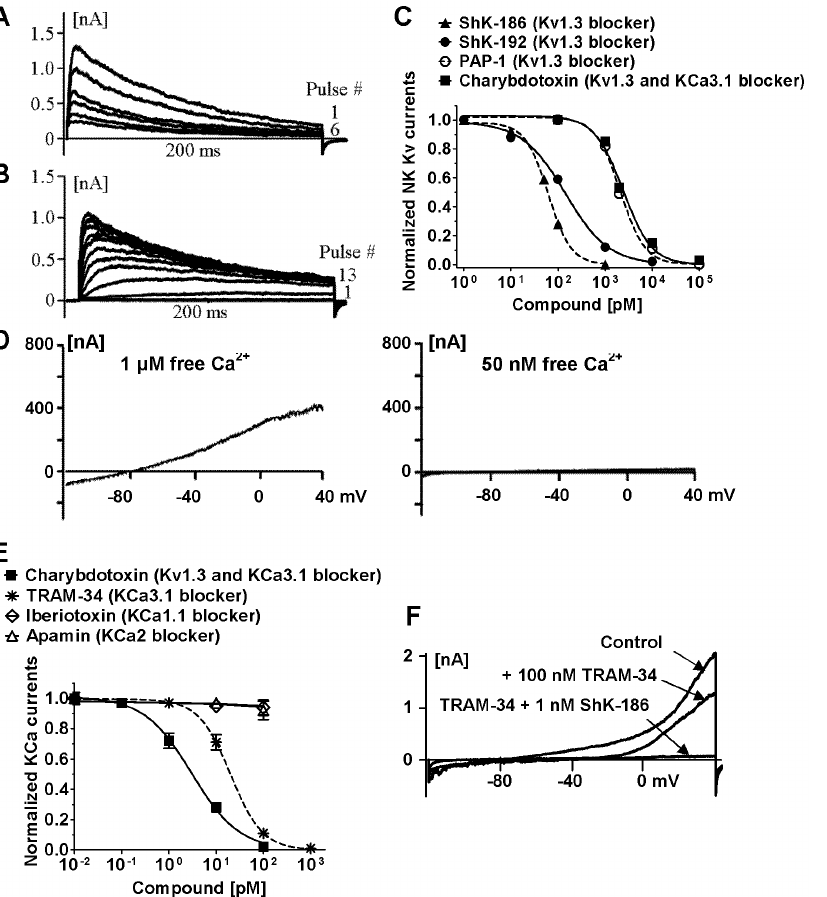
Figure 1. Human NK cells express functional Kv1.3 and KCa3.1. A: Cumulative inactivation of Kv currents. Cells were pulsed to 40 mV from a resting potential of 2 80 mV every second for 200 ms. B: Family of Kv currents. The test potential was changed from 2 60 to 60 mV in 10-mV increments every 30 s. C: Dose-dependent inhibition of Kv currents by ShK-186 ( m ; IC 50 : 61 6 3 pM), ShK-192 ( 2.1 6 0.2 nM), and charybdotoxin ( & ; IC 50 : 2.4 6 0.4 nM). D: KCa currents during 200-ms ramp pulses with an internal solution containing 1 m M or 50 nM free Ca 2 + . E: Dose-dependent inhibition of KCa currents by charybdotoxin ( & ; IC 50 : 3 6 0.4 nM), TRAM-34 (*; IC 50 : 20 6 0.4 nM), iberiotoxin ( e ), and apamin ( D ). F: Complete block of KCa and Kv currents by a combination of TRAM-34 and ShK-186.